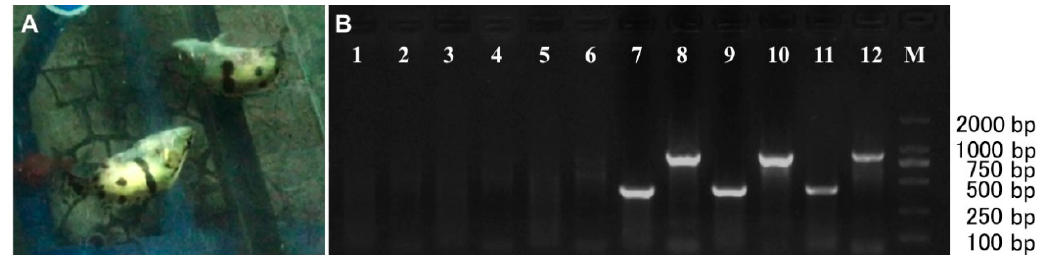
Figure 3. ( A ) The symptom of abnormal swimming of RGNNV-infected Mandarin fish; ( B ) detection of RGNNV in the brains of diseased and non-infected control Mandarin fish. Amplification of the T2 domain (875 bp) and T4 domain (426 bp) of capsid protein gene of RGNNV from brains of three mock-infected (lane 1–6) and RGNNV-infected (lane 7–12) Mandarin fish; M: marker.